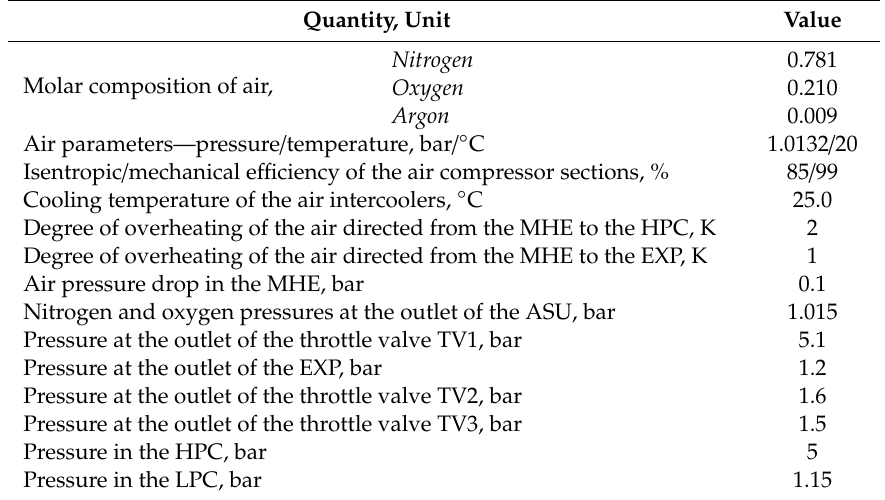
Table 2. Assumptions for the cryogenic ASU (variant V1).